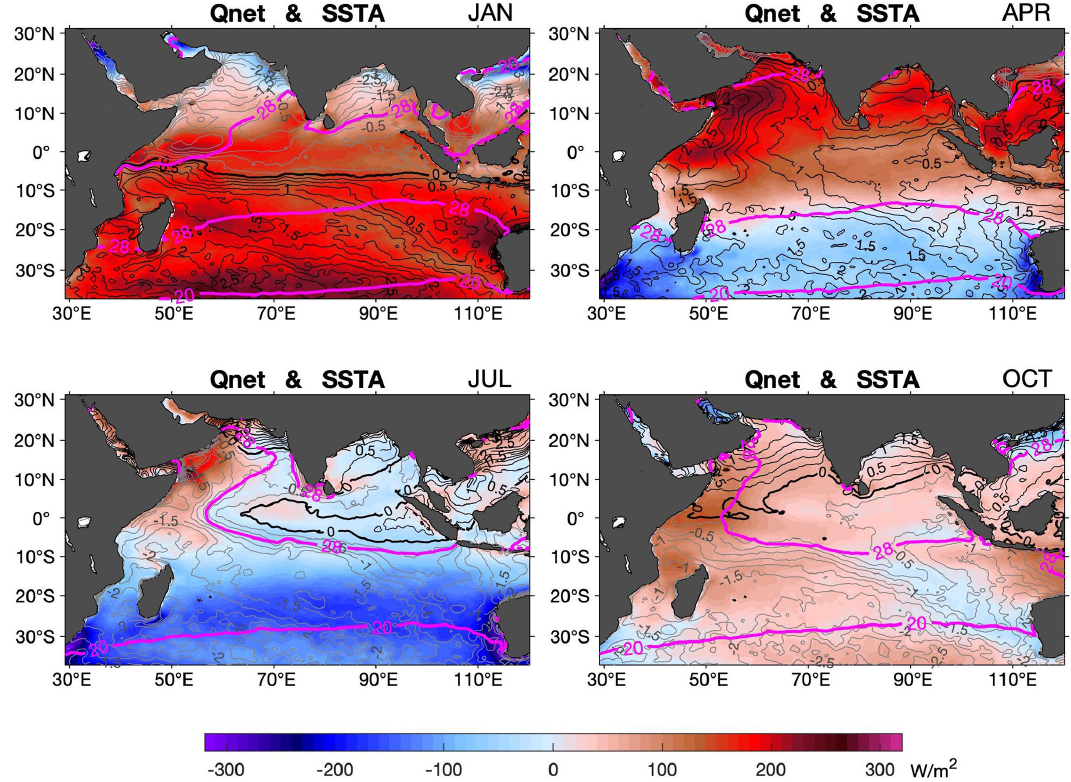
Figure 3. Climatology (2001–2018) of ocean surface net heat input (colour shaded; positive values denote ocean heat gain and negative values ocean heat loss), SST anomaly (black contours) and 20 and 28 ◦ SST contours (pink) for (a) January – NE monsoon, (b) April – transition, (c) July – SW monsoon, and (d) October – transition (adapted from Yu, 2019). Net heat flux is the sum of solar radiation, longwave radiation, and turbulent latent and sensible heat fluxes. The turbulent heat flux climatology was constructed by the OAFlux-HR analysis, and surface radiation climatology was constructed by the NASA CERES EBAF (Kato et al.,